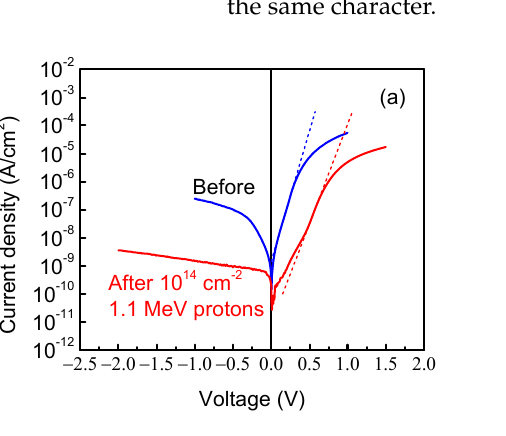
Figure 12. ( a ) room temperature I-Vs before and after proton irradiation; ( b ) the temperature dependence of forward current before and after irradiation.